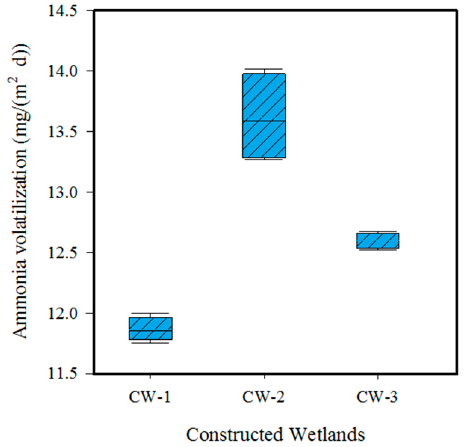
Figure 5. Ammonia volatilization rates of horizontal subsurface ‐ flow constructed wetlands with an HRT of 5 days.